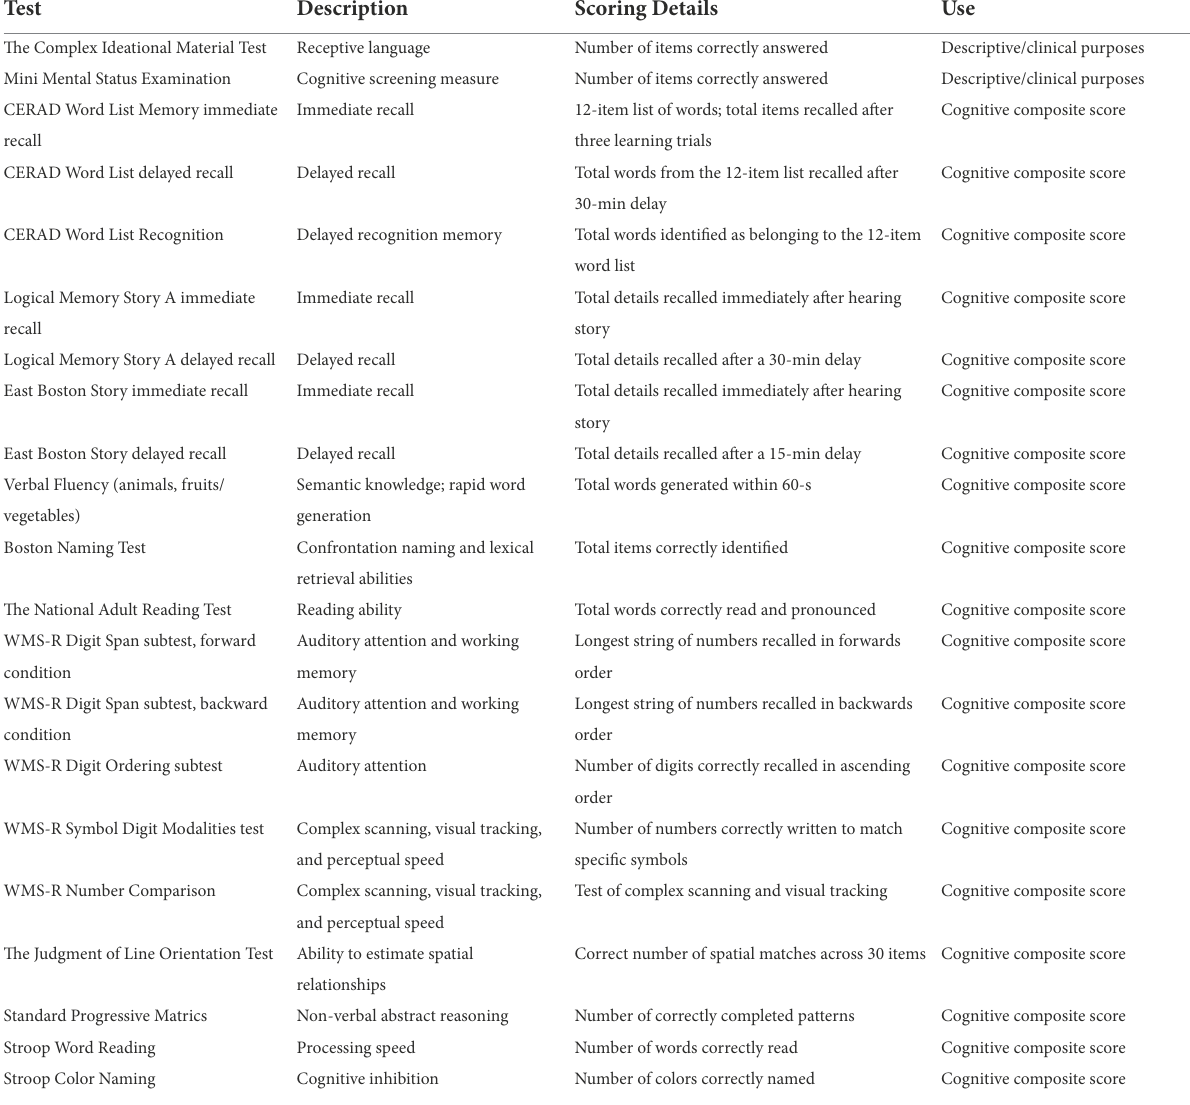
TABLE 1 Description of neuropsychological tests included within the cognitive composite